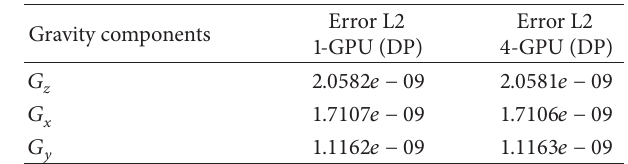
Figure 15: Comparison of the execution times for the calculation of the tensorial components in double precision between a small cluster against a single C2070 card, four C2070 cards in the same workstation, and 8 C2070 cards distributed in two workstations.